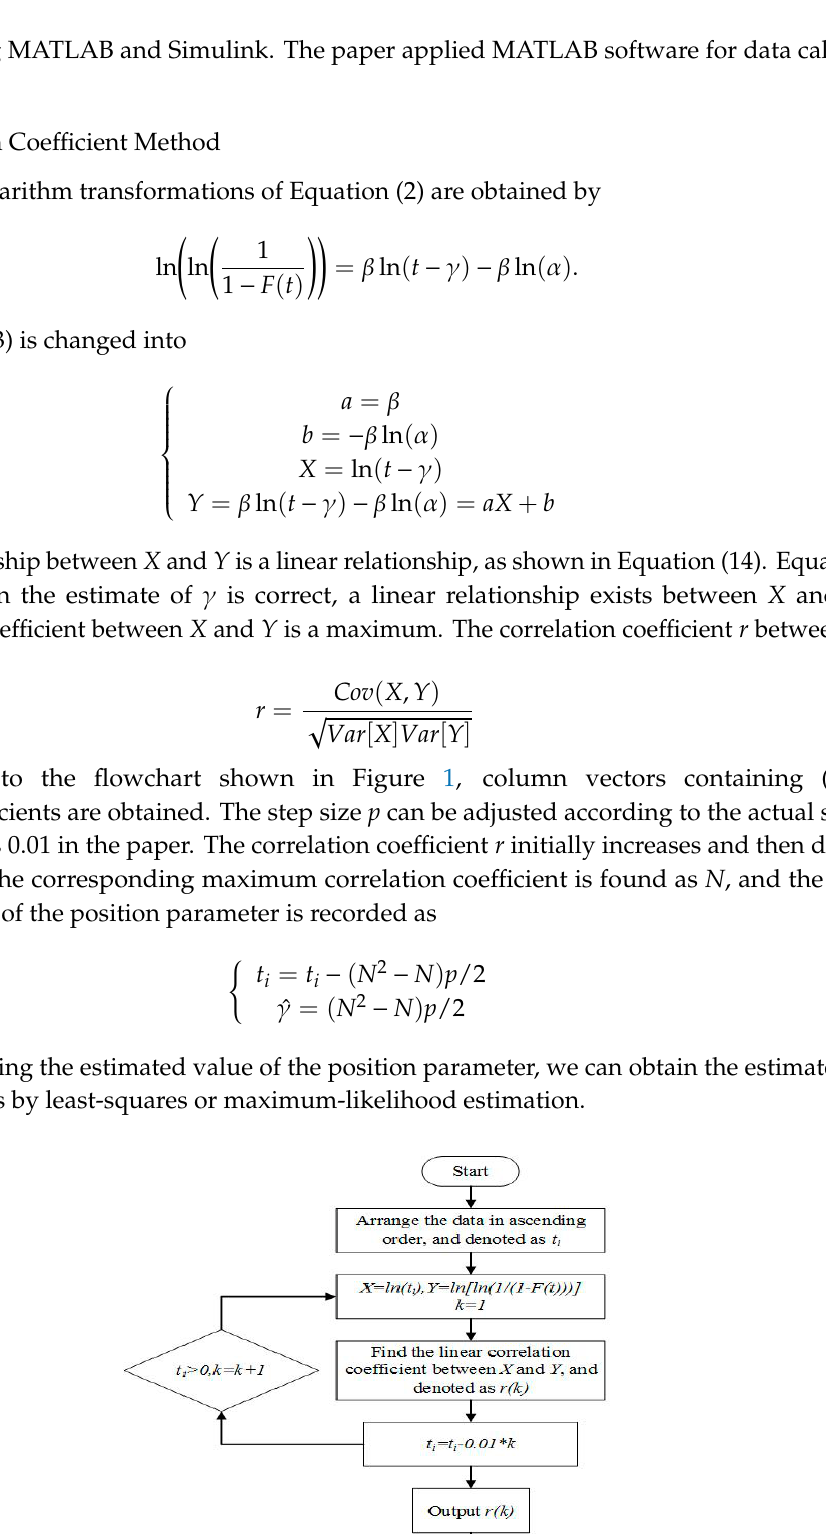
Figure 1. Correlation coefficient method.